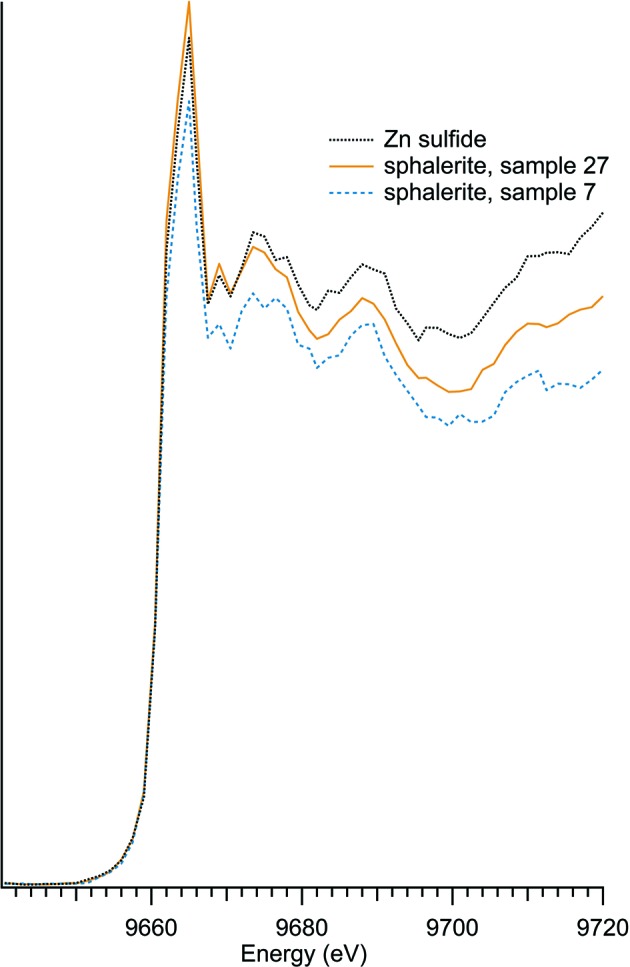
Zinc sulfur spectra.